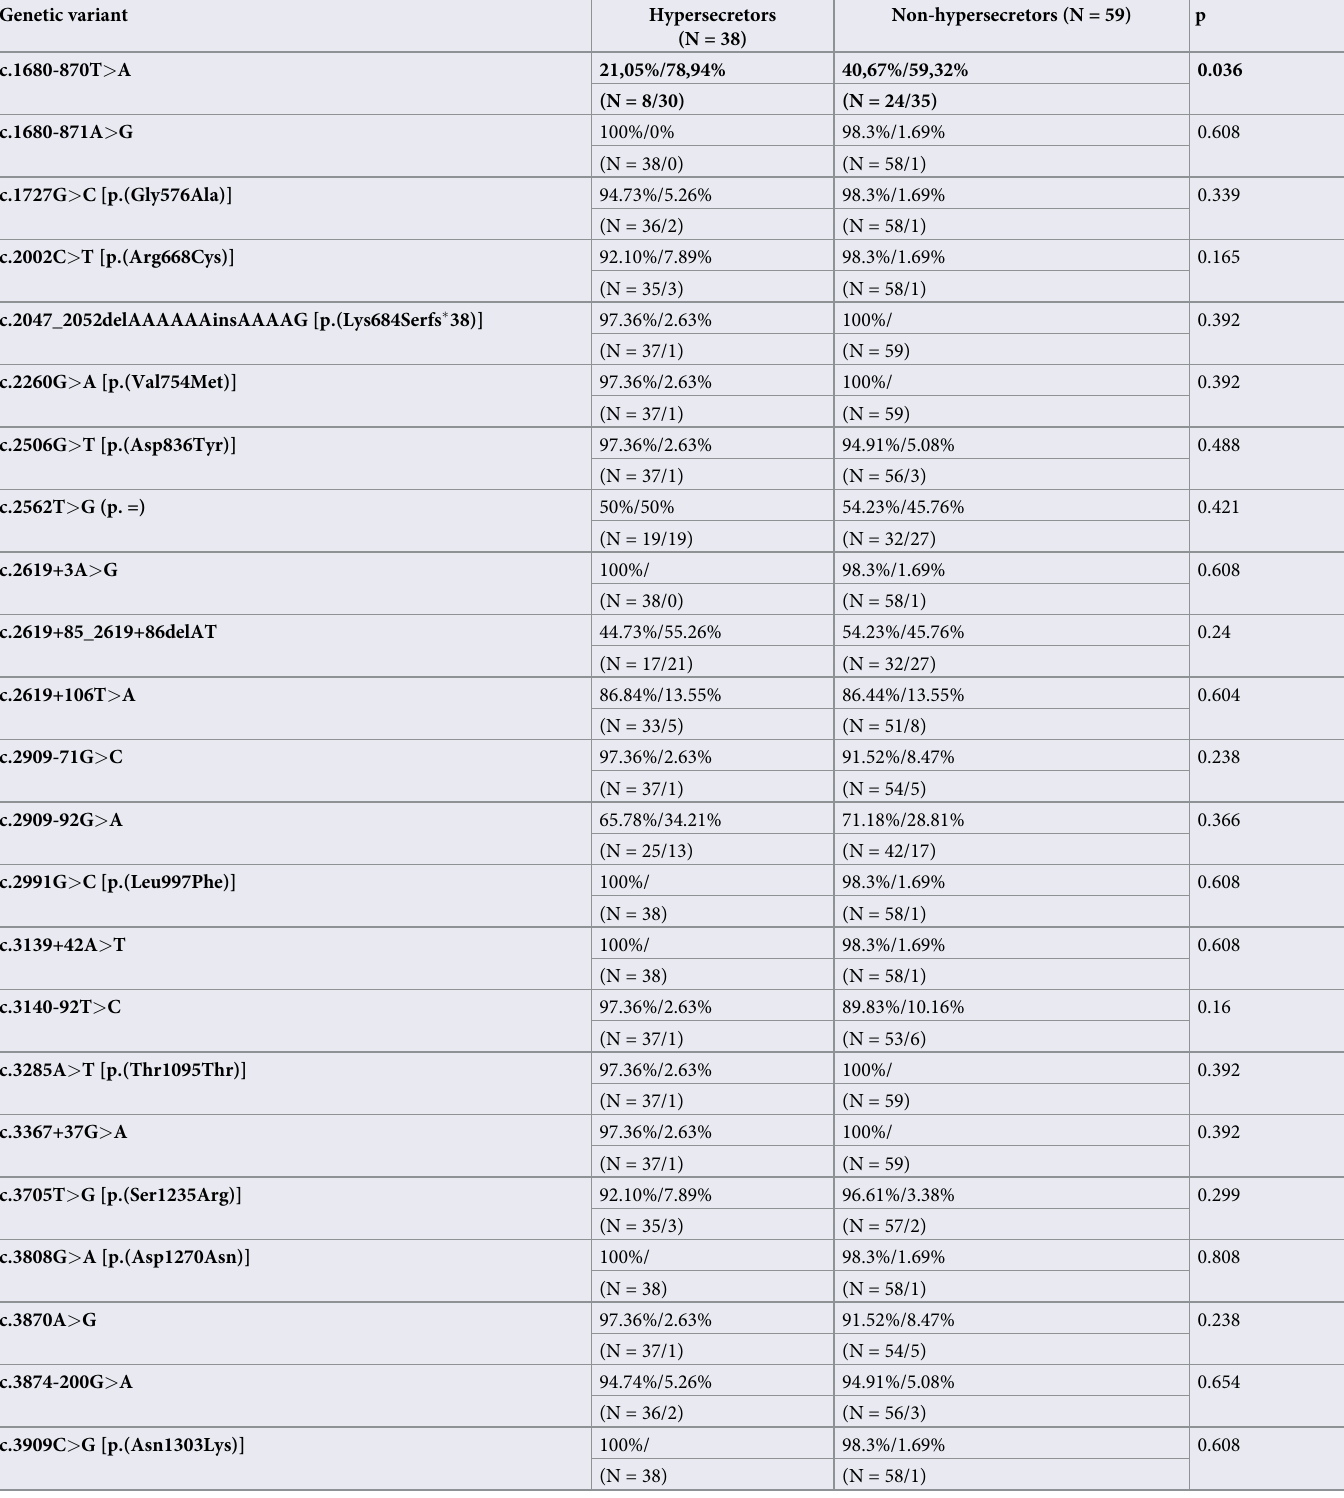
Table 1. Main polymorphisms associated with the CFTR gene in patients with asthma with and without airway mucus hypersecretion. Genetic